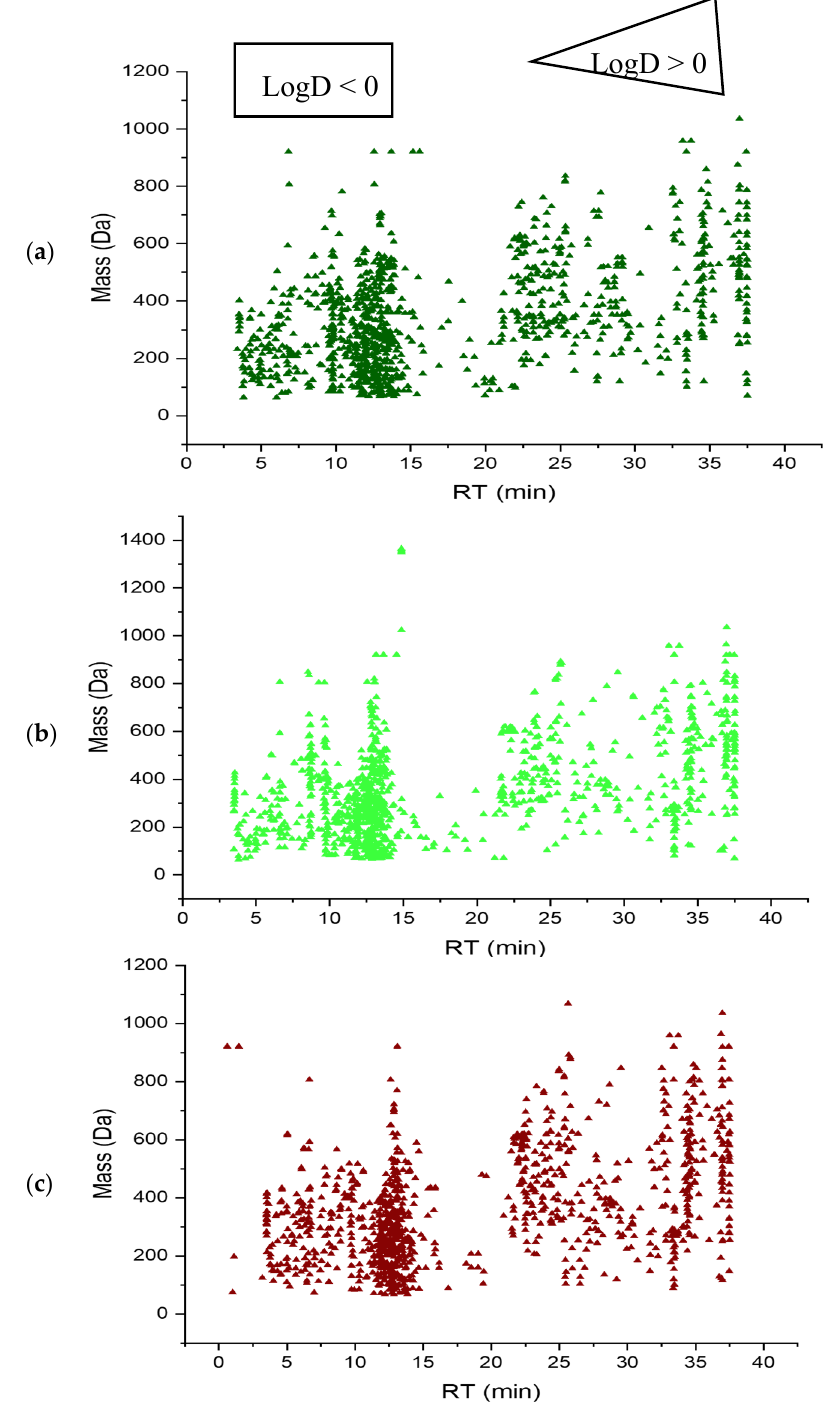
Figure 1. Retention time (RT)/Mass plot of Phragmites australis 100% Methanol extracts analyzed by RPLC-HILIC-ESI-TOF-MS in positive electrospray ionization mode. ( a ) Leaf; ( b ) Rhizome; ( c ) Root, which showed the features’ separation according to their polarity and detected according to their m/z .